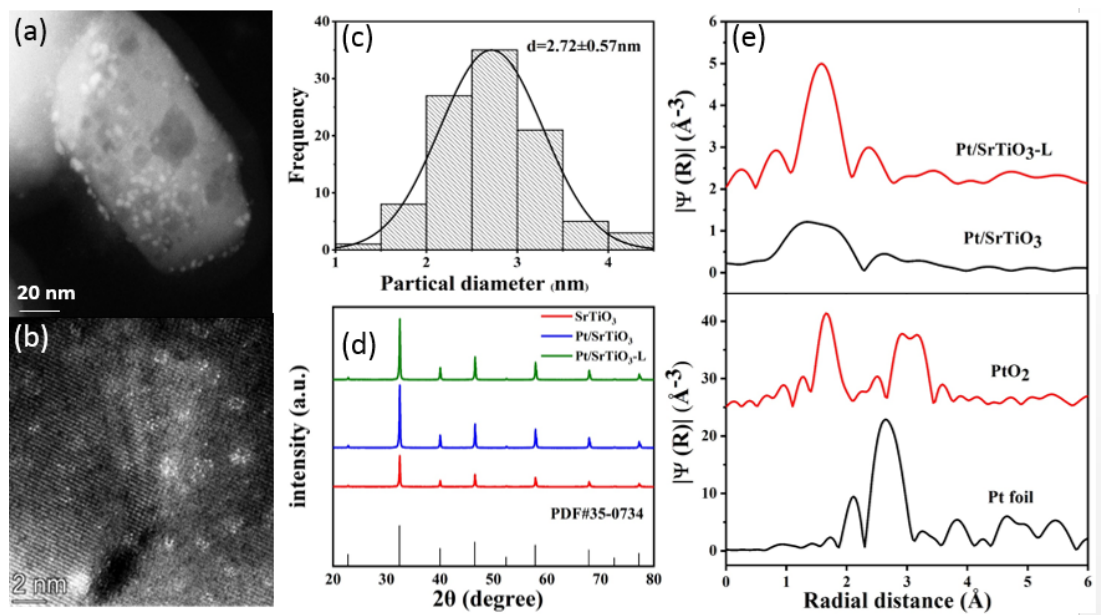
Figure 2. STEM photos of ( a ) Pt/SrTiO 3 and ( b ) Pt/SrTiO 3 -L, ( c ) size distribution of Pt particles on Pt/SrTiO 3 and ( d ) XRD profiles of catalysts, ( e ) Fourier transform of extended X-ray absorption fine structure (EXAFS) spectra of Pt L3 edge for Pt/SrTiO 3 and Pt/SrTiO 3 -L catalysts.